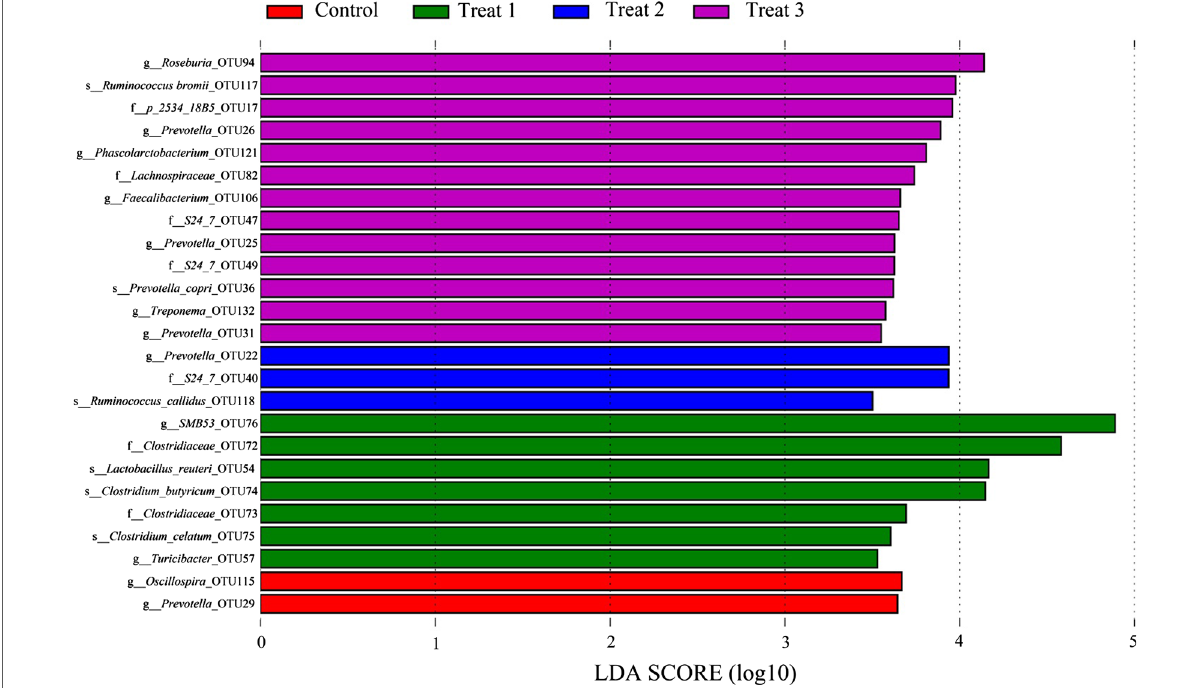
Fig. 3 Differences in the pig gut microbiota among the different fermented Mao-tai lees (FML) treatments. Linear discriminant analysis (LDA) effect size (LEfSe) results show that bacterial OTUs/markers were significantly different in abundance between control and FML-treated